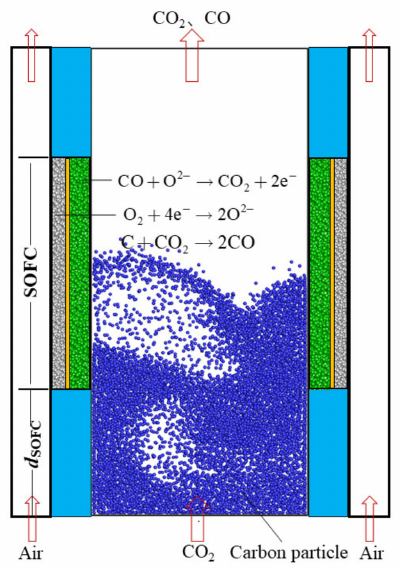
Figure 1. Model of fluidized bed gasifier coupled with